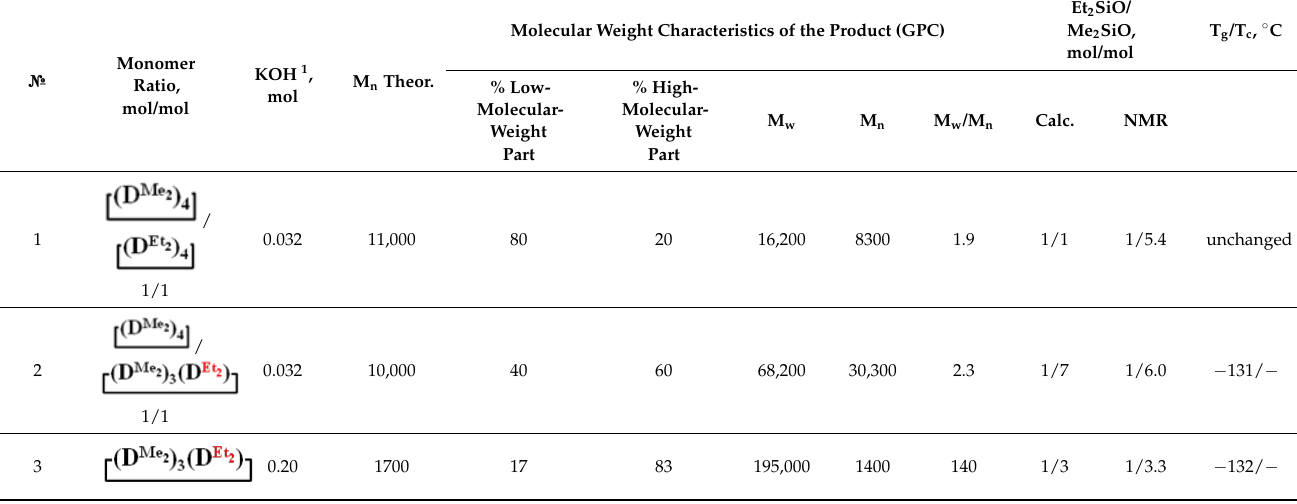
Table 3. Polymerization conditions and characteristics of products.